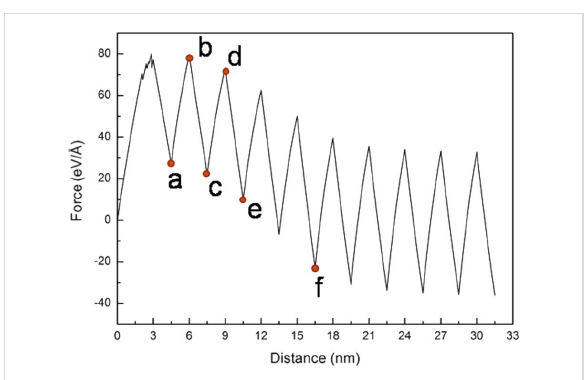
Figure 5: Force–distance curve of Ni under ten times of cyclic loading, where the first tension distance of the sample was 3 nm, and the subsequent compression and tension distances were 1.5 nm. The letters a–f represent the observation positions for the crack growth diagrams in Figure